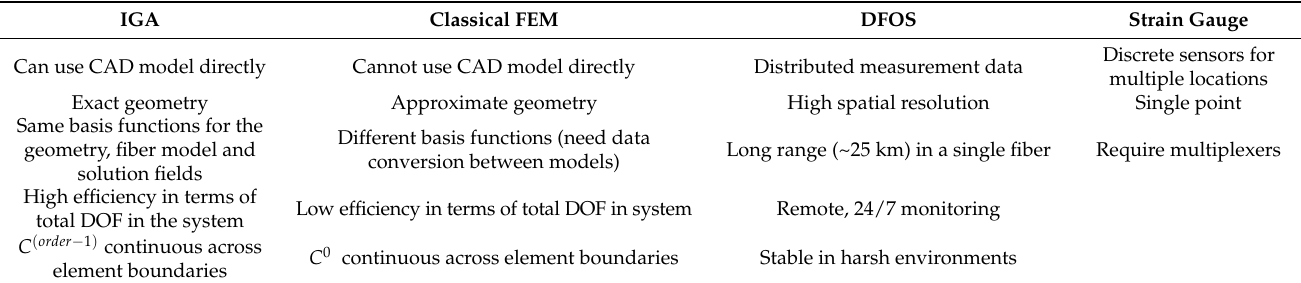
Table 1. Comparison of proposed technologies with traditional technologies.